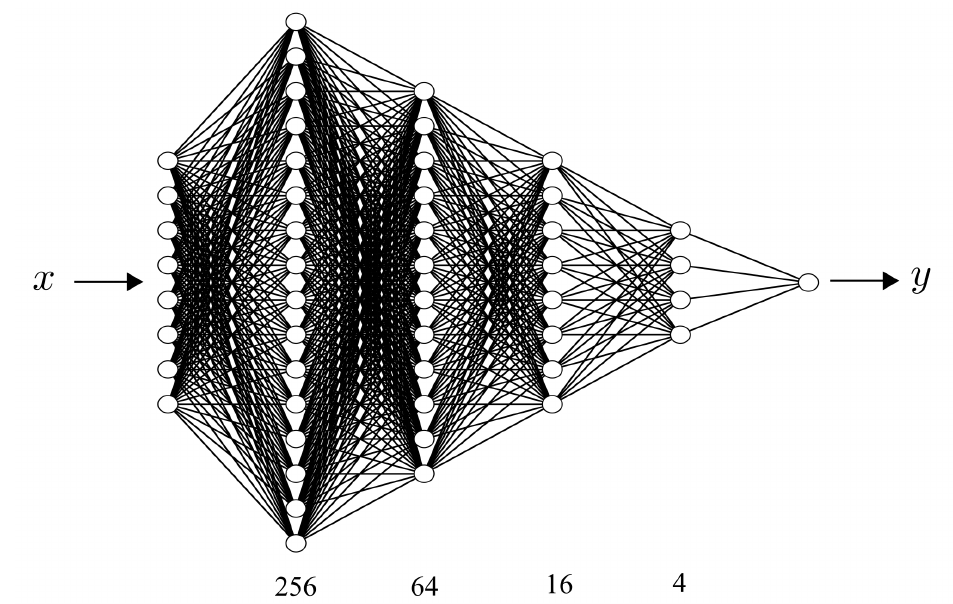
Figure 6. Architecture of the deep neural network